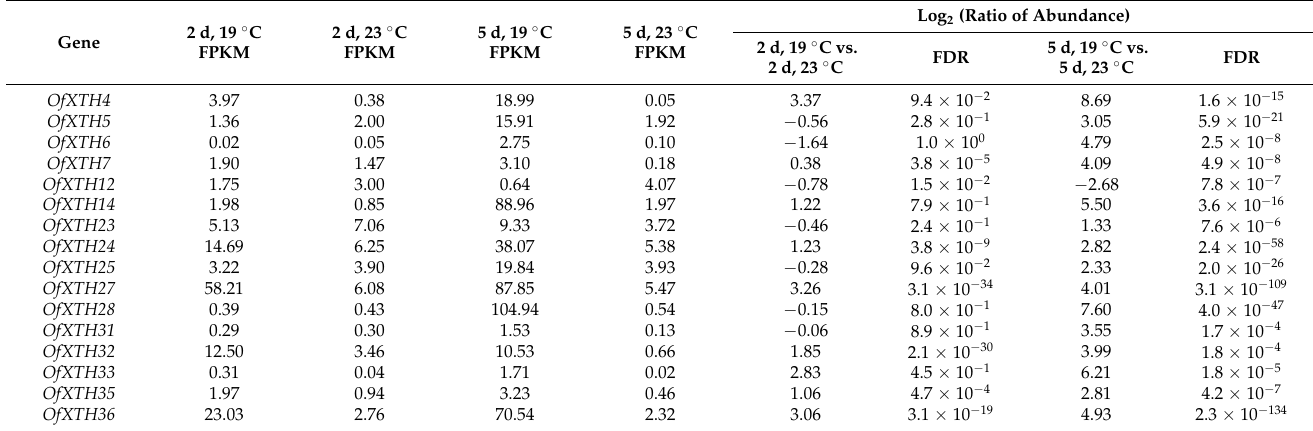
Table 3. DEGs of OfXTHs treated at 19 ◦ C and 23 ◦ C for 2 and 5